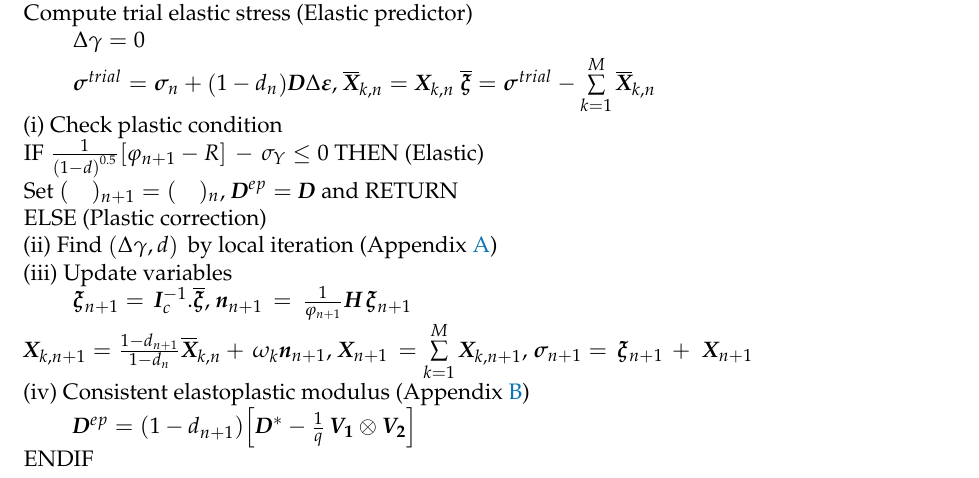
Table 1. Integration scheme of the coupled plastic-damage (UMAT). Compute trial elastic stress (Elastic predictor) ∆ γ =